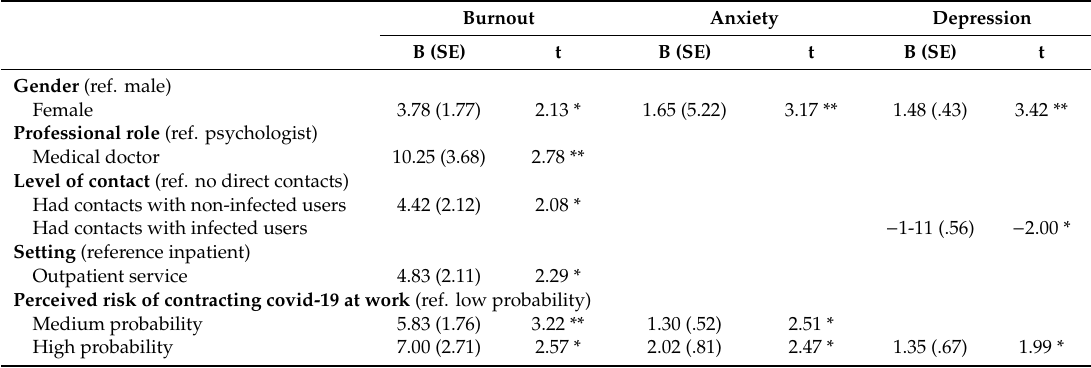
Table 4. Determinants of burnout, anxiety and depression, univariate linear models. Only significant coe ffi cients and variable levels are